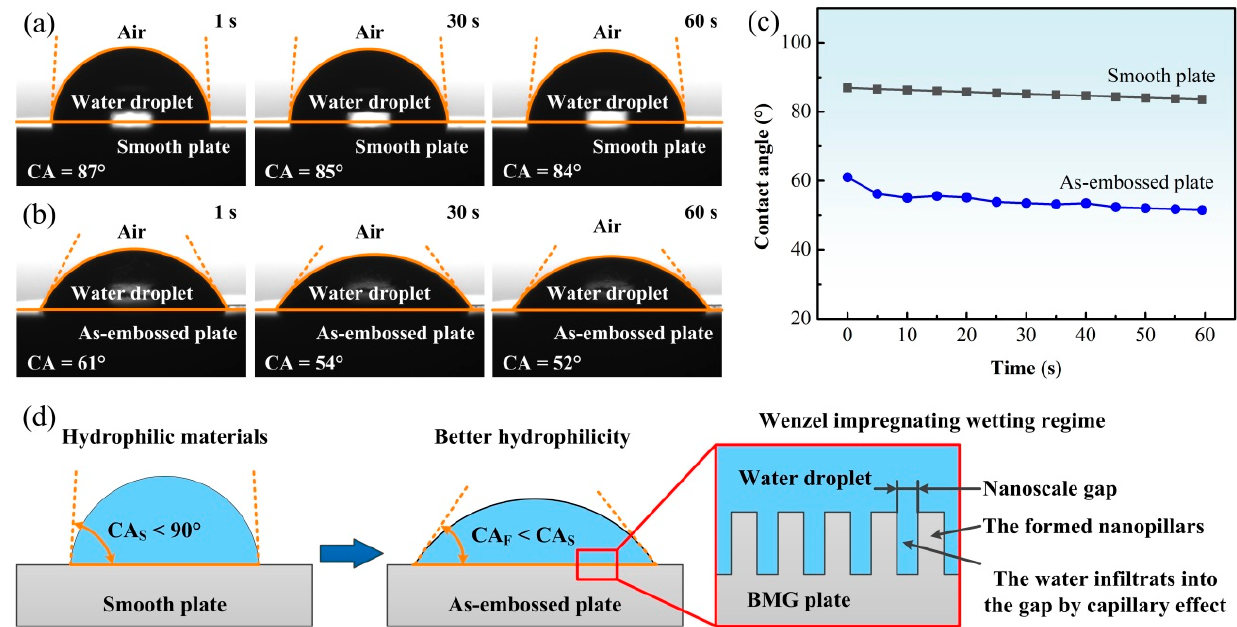
Figure 8. ( a ) Contact angle on the smooth ZrY 1.5 BMG plate. ( b ) Contact angle on the ZrY 1.5 BMG plate with nanostructure array. ( c ) The variations of water contact angle on the BMG surface before and after non-isothermal embossing. ( d ) Diagrammatic sketch of a water droplet in contact with the ZrY 1.5 BMG plate with nanostructure (Wenzel’s model).